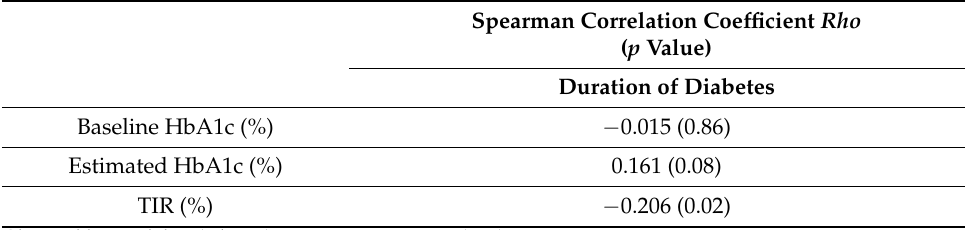
Table 13. Correlation of duration of diabetes with baseline HbA1c and TIR